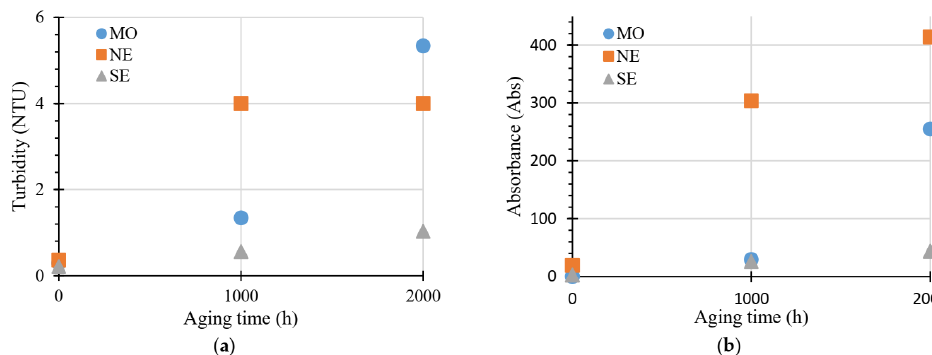
Figure 2. Liquid properties as a function of thermal aging: ( a ) Turbidity of fresh and aged liquids ( b ) Absorbance of fresh and aged liquids.